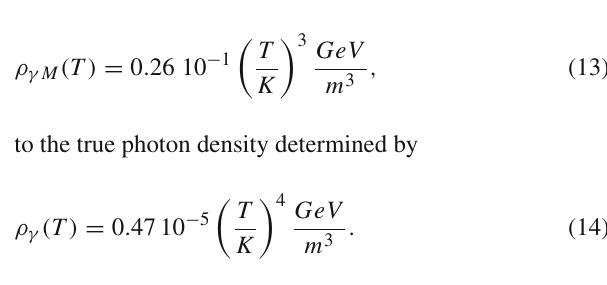
Fig. 2 Number of e-foldings as a function of the decimal Log of the reheating temperature in Kelvin leading to a number density incompatible with standard cos- mology. Thus we are lead to inflation.